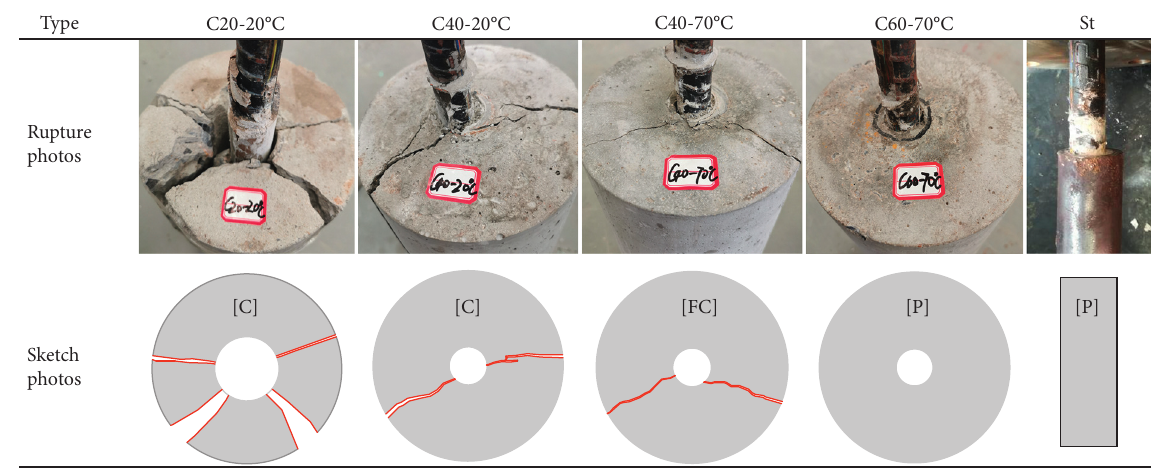
Figure 13: Failure mode of anchor loss of pull-out specimens.